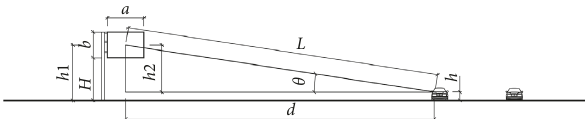
Figure 4: The cross-section of traffic sign setting on the curved highway (for details, refer to the